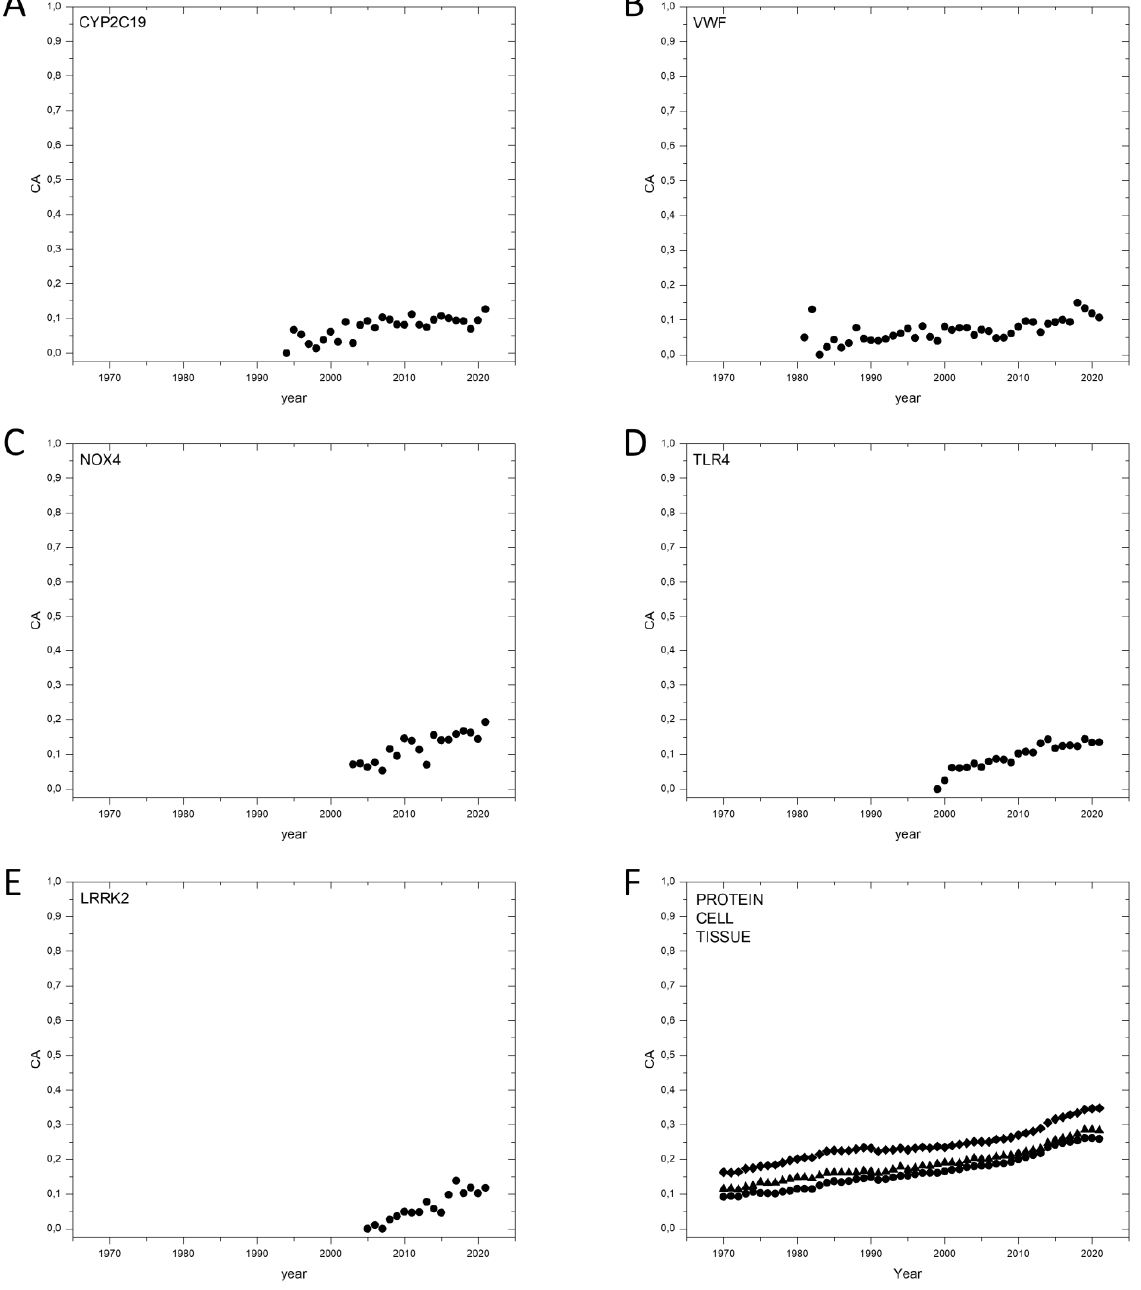
Figure 2. Dynamics of CA (Cancer_Pubs/All_Pubs) parameters of selected human bystander genes defined by Bányai et al., 2021 [3]. ( A ): CYP2C19 , Cytochrome P450 2C19. ( B ): VWF , von Willebrand factor. ( C ): NOX4 , NADPH oxidase 4. ( D ): TLR4 , Toll-like receptor 4. ( E ): LRRK2 , Leucine-rich repeat serine/threonine-protein kinase 2. ( F ): terms: “protein” (black circle); “cell” (black diamond); “tissue” (black triangle).